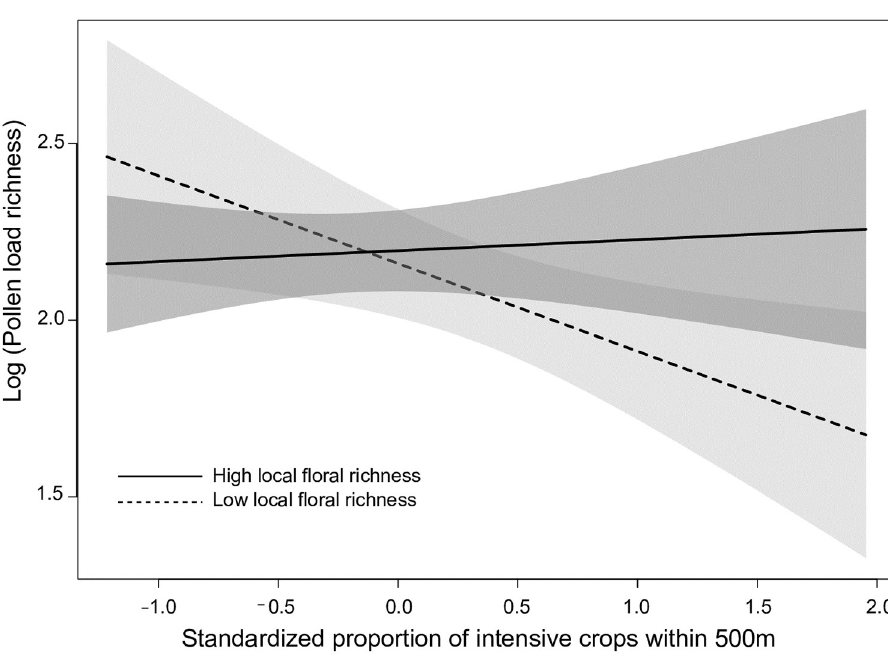
Fig 3. Species richness found in pollen loads of 205 Bombus impatiens workers as a function of the interaction between the proportion of intensive crops (500-m radius) and local floral richness (100-m radius). Workers were captured from 20 clusters composed of 4 experimental colonies of Bombus impatiens monitored in 2016 in Southern Que´bec, Canada. The dotted and solid lines represent pollen load richness when local floral richness was low ( < 8) and high ( � 8 species), respectively. Model-averaged predictions under average conditions are shown with 95% unconditional confidence